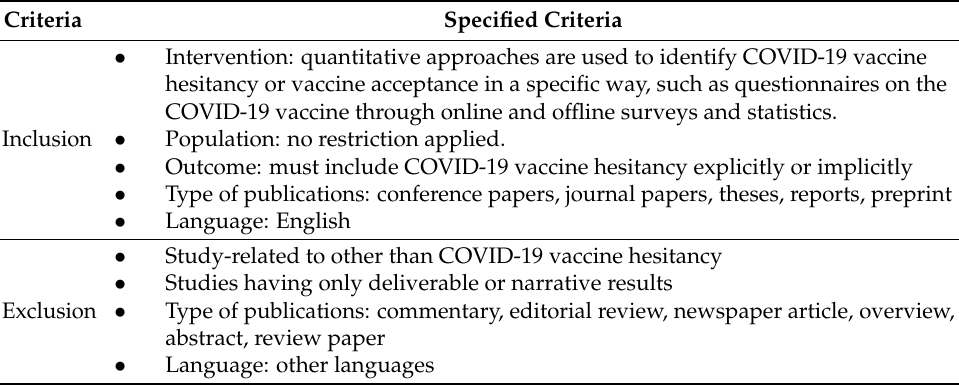
Table 1. Inclusion and exclusion